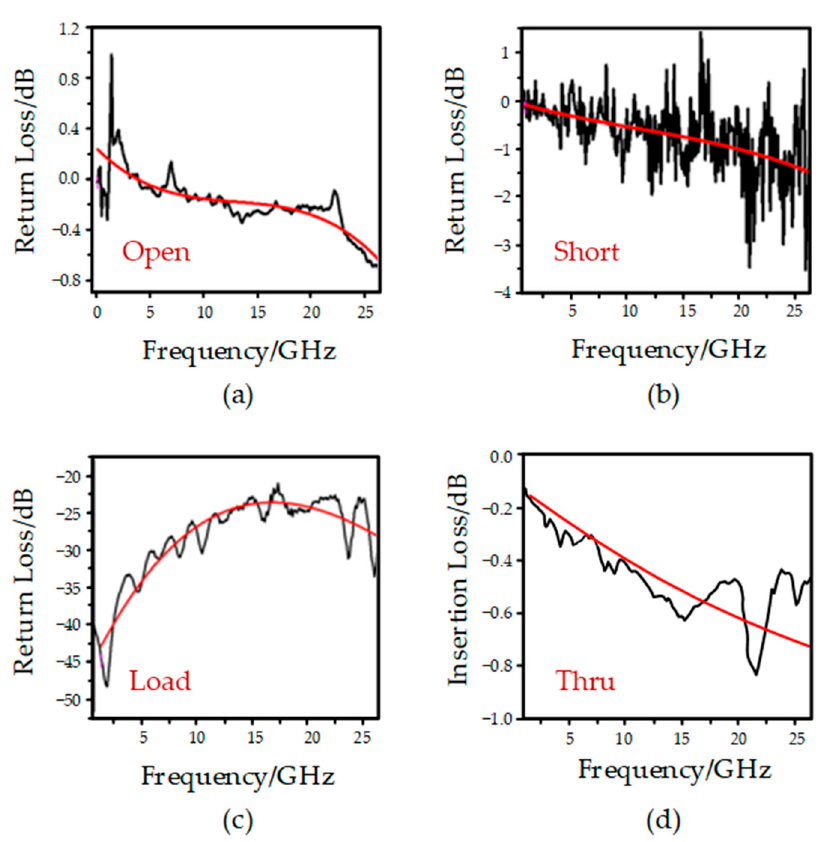
Figure 7. Test results for each status: ( a ) Open circuit; ( b ) short circuit; ( c ) load circuit; ( d ) Thur circuit.